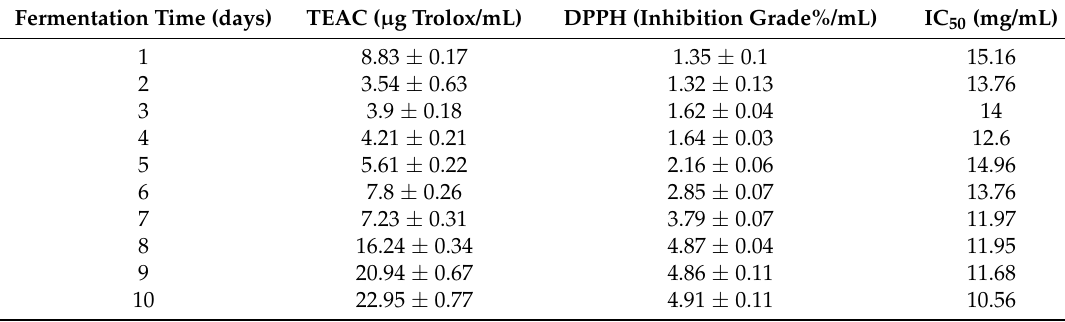
Table 1. Time-dependent antioxidant capacity of Kombucha vinegar with added pollen.